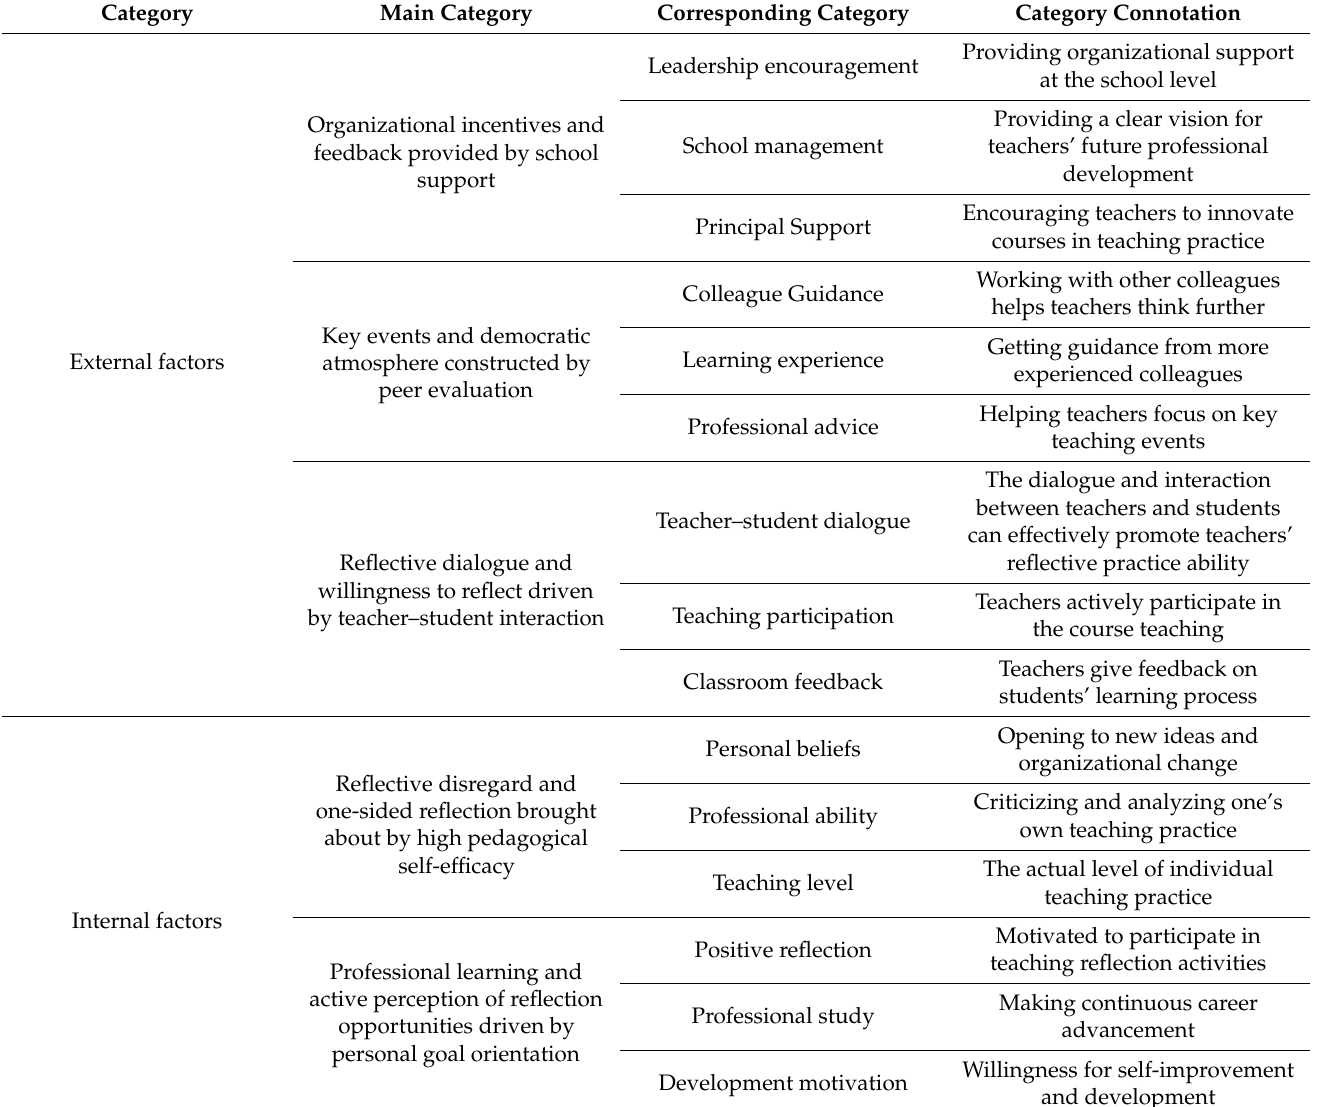
Table 7. Qualitative Phase Coding